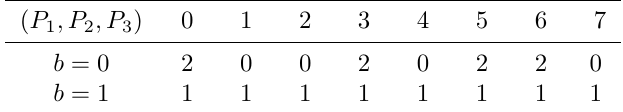
Table 1: Histogram of the joint distribution of ( P 1 , P 2 , P 3 ) for b = 0 and b = 1. ( P 1 , P 2 , P 3